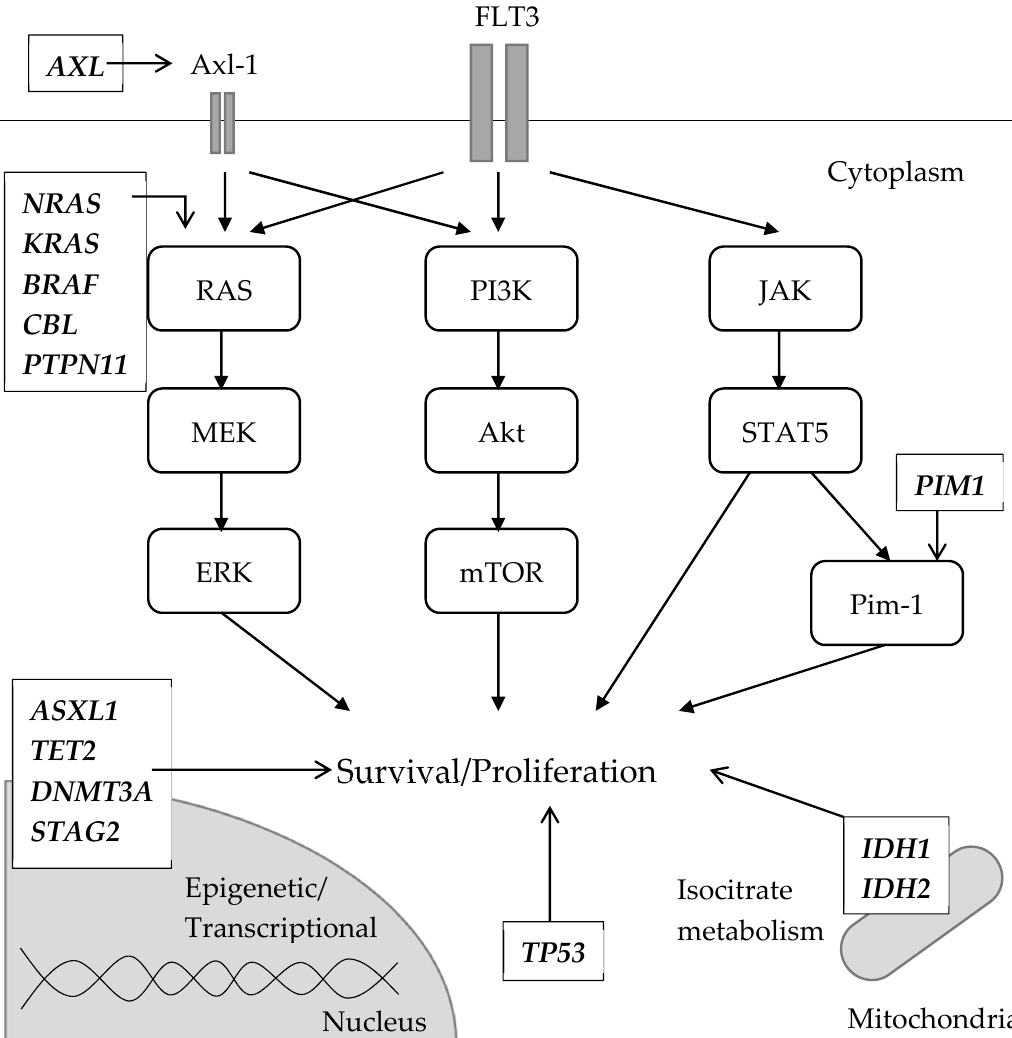
Figure 3. Schematic description of genetic abnormalities (mutations or upregulation) associated with secondary off-target resistance to FLT3 inhibitors. Mutations involved in the RAS/MAPK pathway were reported. NRAS mutation is the most common among them. Axl-1, coded by the AXL gene, is a receptor tyrosine kinase that leads to the activation of RAS/MARK and PI3K/Akt/mTOR pathway. The upregulation of the AXL gene was observed in midostaurin-resistant AML cell lines. Pim-1 is part of the downstream signaling of STAT5, contributing cell survival and proliferation as well as cell migration. A lestaurtinib-resistant AML cell line showed the overexpression of Pim-1. Other gene mutations commonly seen in AML regardless of FLT3 status were also detected. Although a direct relationship with FLT3 signaling was not suggested, these mutations have an essential role in maintaining leukemic clones by modulating epigenetic/transcriptional regulations (e.g., ASXL1 , TET2 , DNMT3A and STAG2 ), altering the metabolism of the citrate acid cycle (e.g., IDH1 and IDH2 ) and preventing apoptosis (e.g., TP53 ).